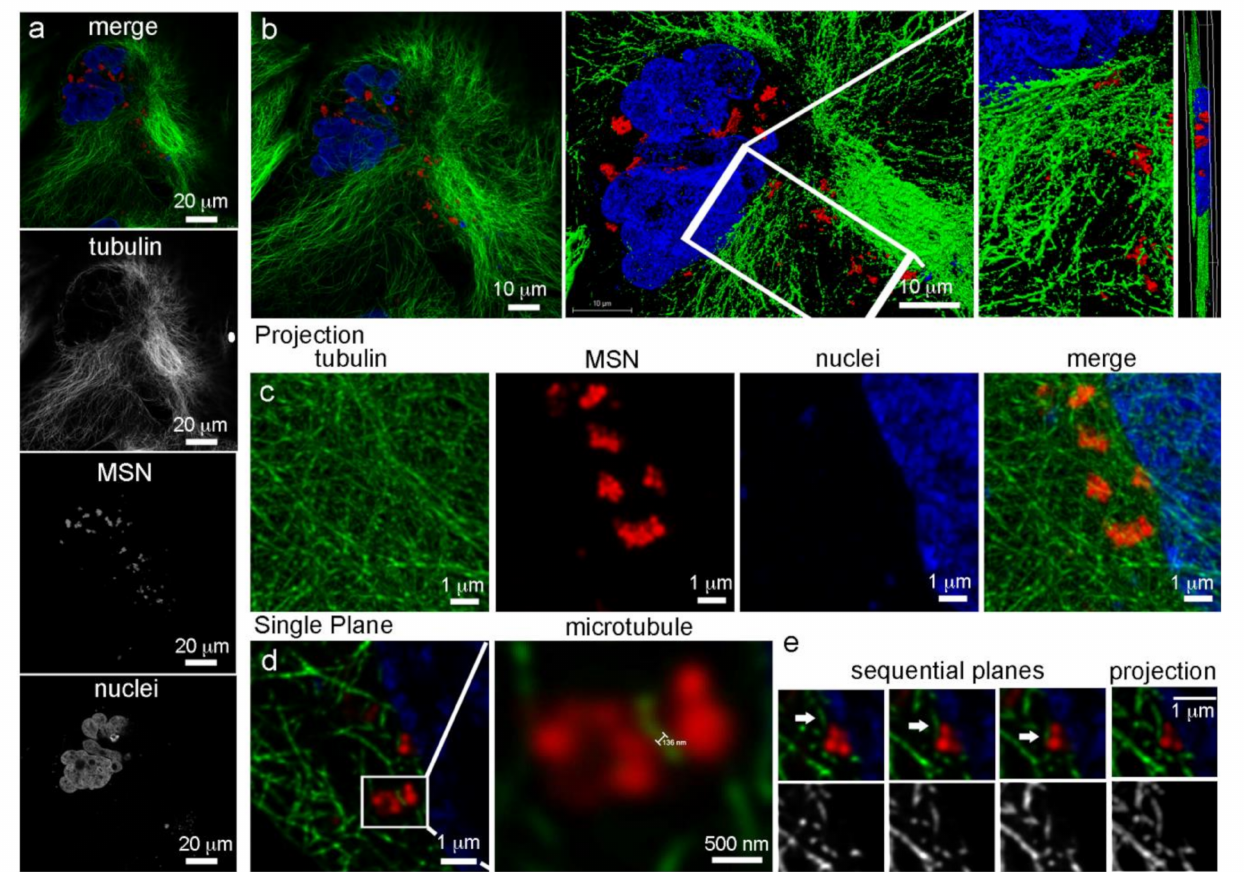
Figure 2. Microtubule highways in HeLa cells. ( a , b ) Single plane and 3D confocal micrographs showing individual fluorophore and merged images of a HeLa cell incubated with MSN for 24 h [microtubules in green (AF488), nuclei in blue (DAPI), and MSN in red (DyLight 633)]. ( c ) High magnification single and merged fluorophore projection images showing perinuclear MSN-laden endosomes and their association with microtubules. ( d , e ) Single plane and projection deconvoluted micrographs showing MSN association with single microtubule filaments. The size bar in “d” shows resolution at 136